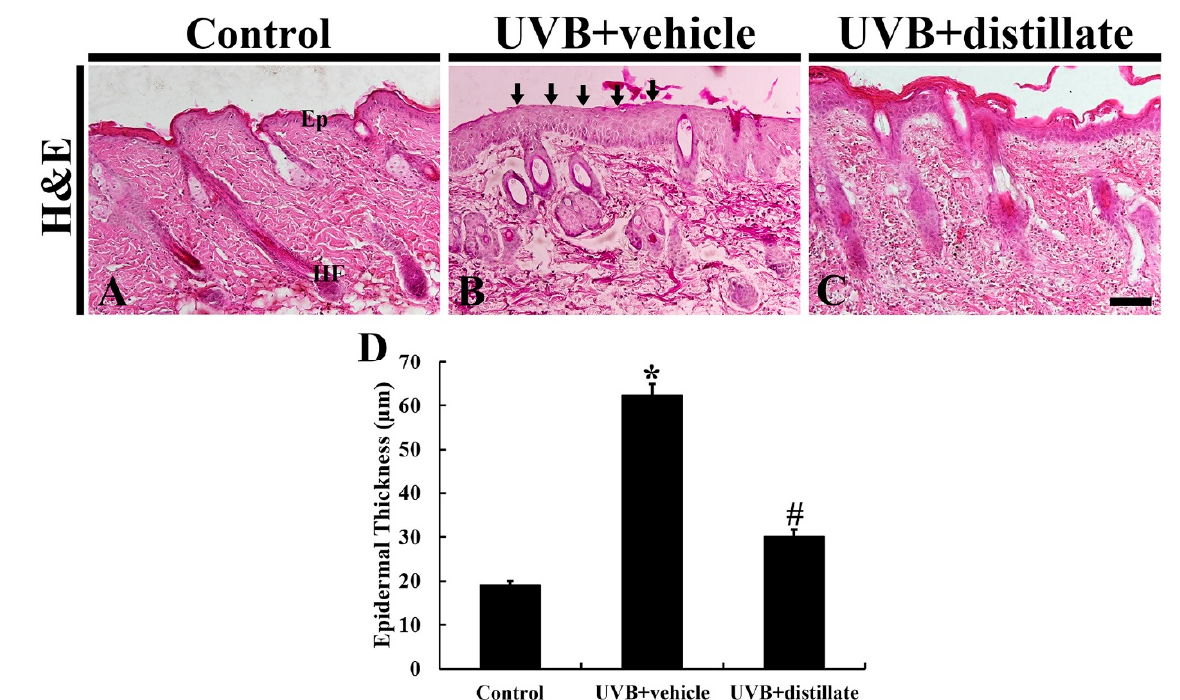
Figure 3. H and E staining of mouse dorsal skin in the control ( A ), UVB + vehicle ( B ), and UVB + distillate ( C ) groups at 5 days after UVB exposure. In the UVB + vehicle group, the thickness of the epidermis was significantly increased (arrows) at 5 days after UVB exposure. However, in the UVB + distillate group, the epithermal thickness was significantly reduced. Ep, epidermis; HF, hair follicle. Scale bar = 100 μ m. ( D ) The mean epidermal thickness in the control, UVB + vehicle, and UVB + groups at 5 days after UVB exposure. The data represent mean ± standard errors of means ( n = 10/group, * p < 0.05 vs. control group; # p < 0.05 vs. UVB+vehicle group).